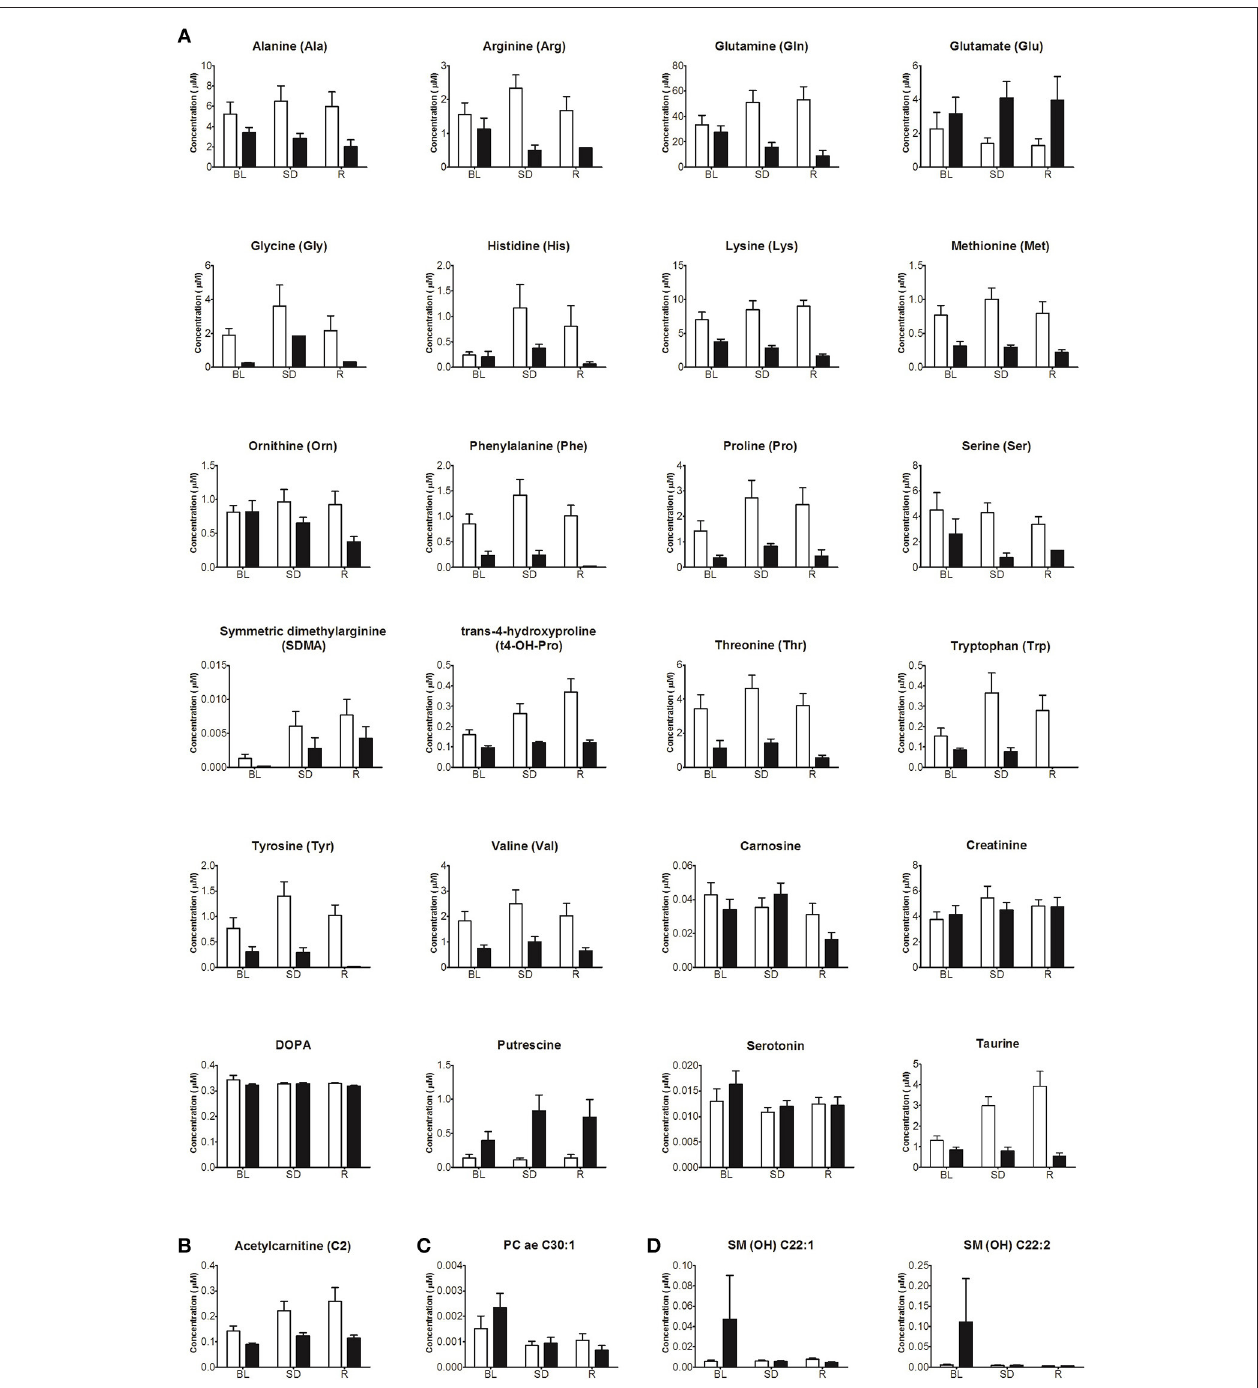
FIGURE 8 | Concentrations (mean ± SEM) of the 28 metabolites at baseline (BL), sleep deprivation (SD) and recovery (R) in control (white) and hyperammonemic (black) animals. Metabolites are presented by class: (A) Amino acids and Biogenic Amines, (B) Acylcarnitines, (C) Phosphatidylcoline acyl-akyl, and (D) Sphingolipids.